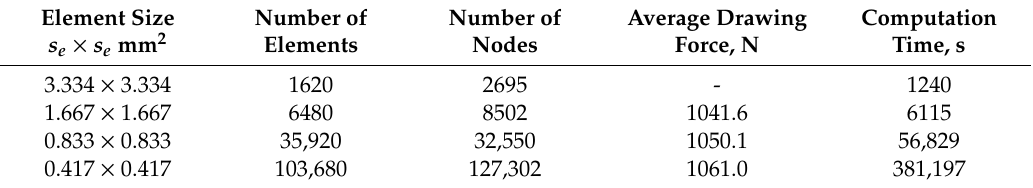
Figure 9. Distribution of von Mises equivalent plastic strain in the specimen discretised with elements with a size of s e = 3.334 mm. Table 4. Parameters and results of